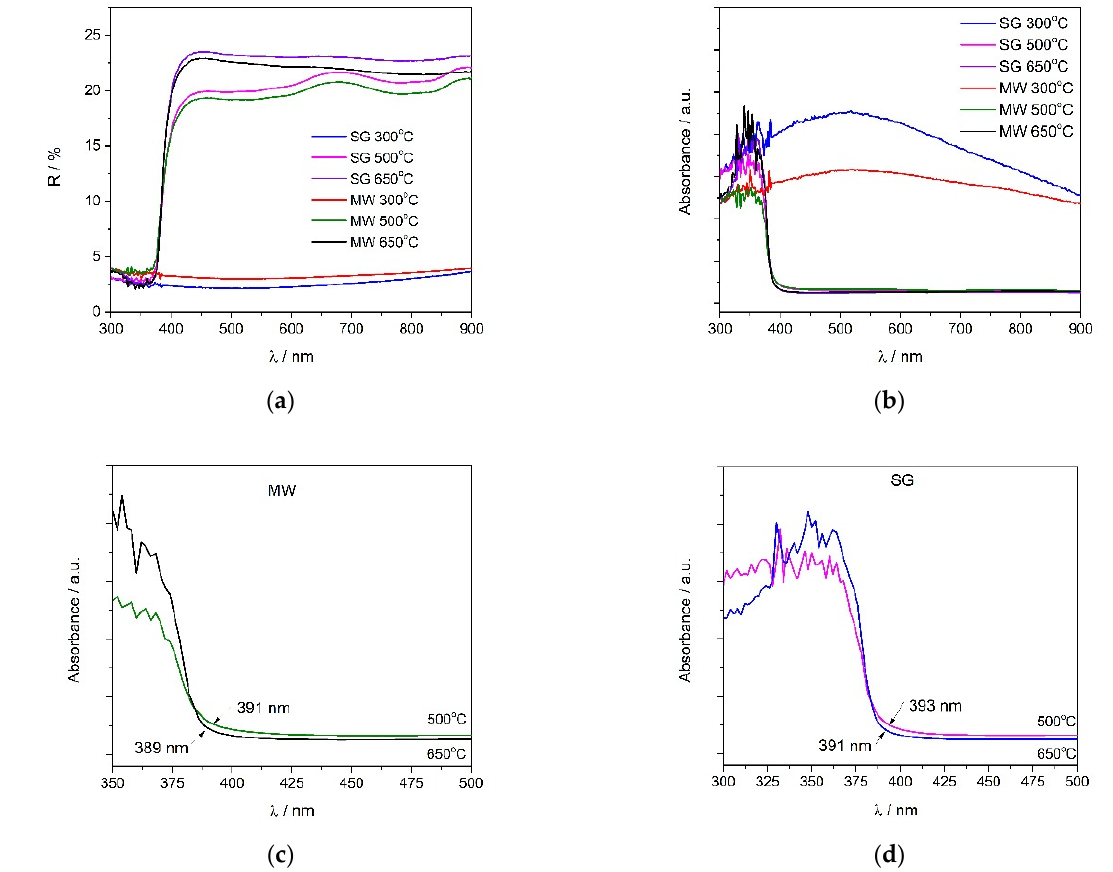
Figure 7. UV–Vis: ( a ) reflectance spectra; ( b ) absorbance spectra of the thermally treated powders at 300 °C, 500 °C, and 650 °C; ( c ) absorbance spectra in the 350–500 nm range for the microwave assisted sol–gel method (MW); and ( d ) absorbance spectra in the 350–500 nm range for the sol–gel method (SG).